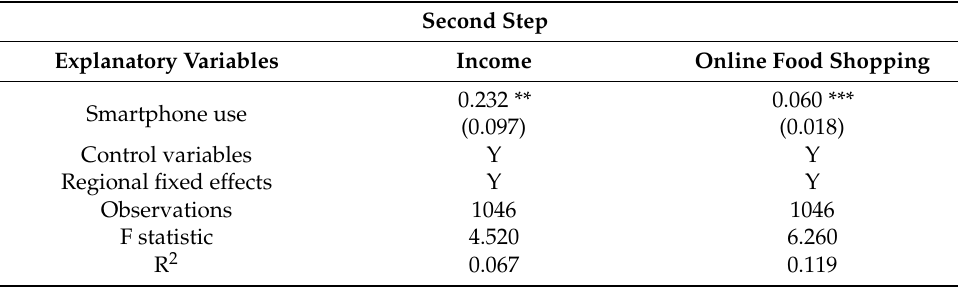
Table 7. Mechanism analysis: Step